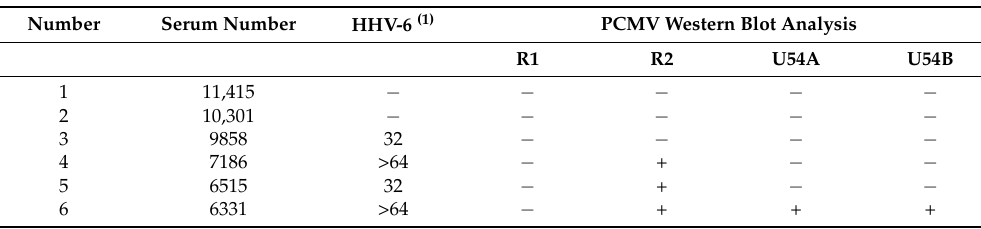
Table 4. Correlation between the reactivity against porcine cytomegalovirus (PCMV) and human herpesvirus-6 (HHV-6).